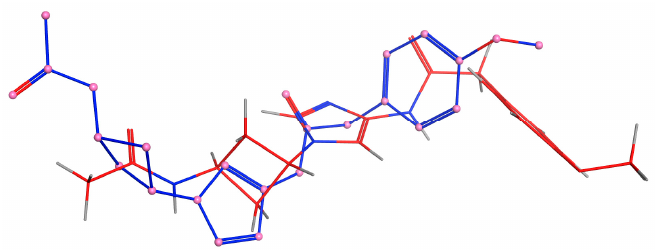
Figure 8. RMSD discrepancy between the docked molecule (in red) and the downloaded reference compound (in blue). compound (in